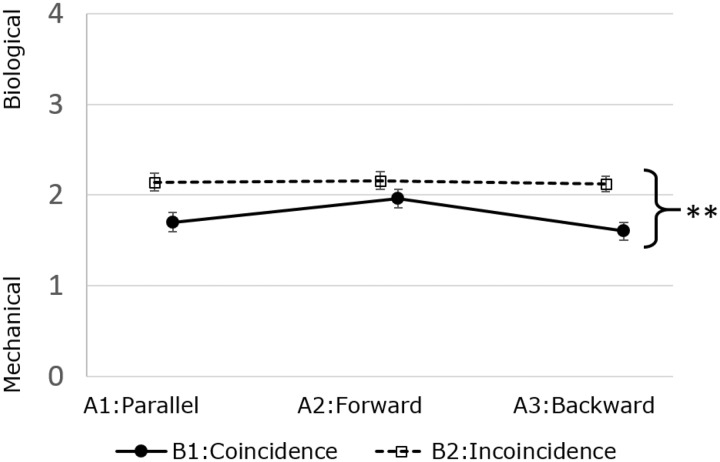
Two-way repeated-measure ANOVA for Item 2: mechanical–biological. **p < .01. Error bars represent standard errors.